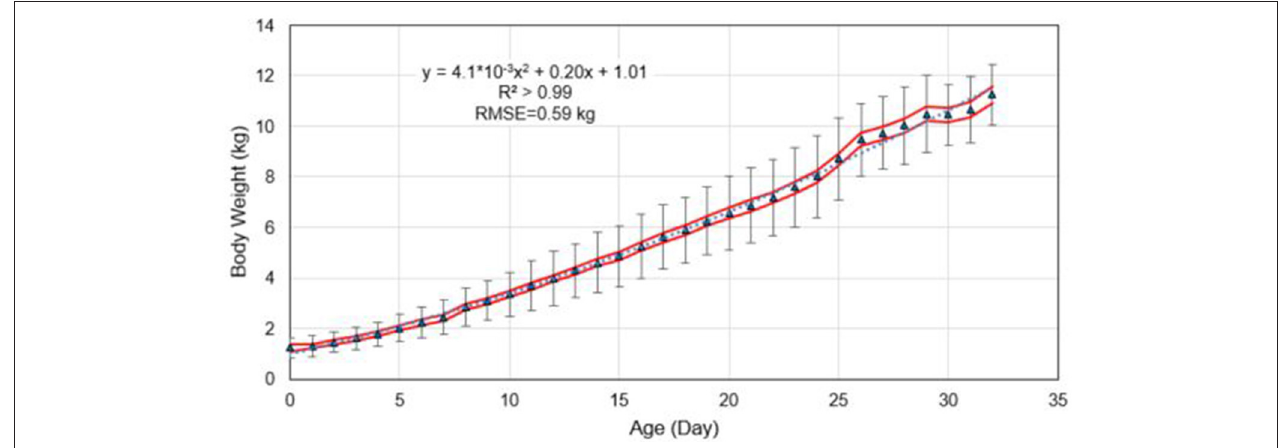
FIGURE 2 | Litter average piglet body weight (y axis) vs. day of age (x axis). Error bars represent one standard deviation of the mean. Red lines represent the 95% CI of the mean. Blue dotted line represents the fitted line for the second order polynomial equation.